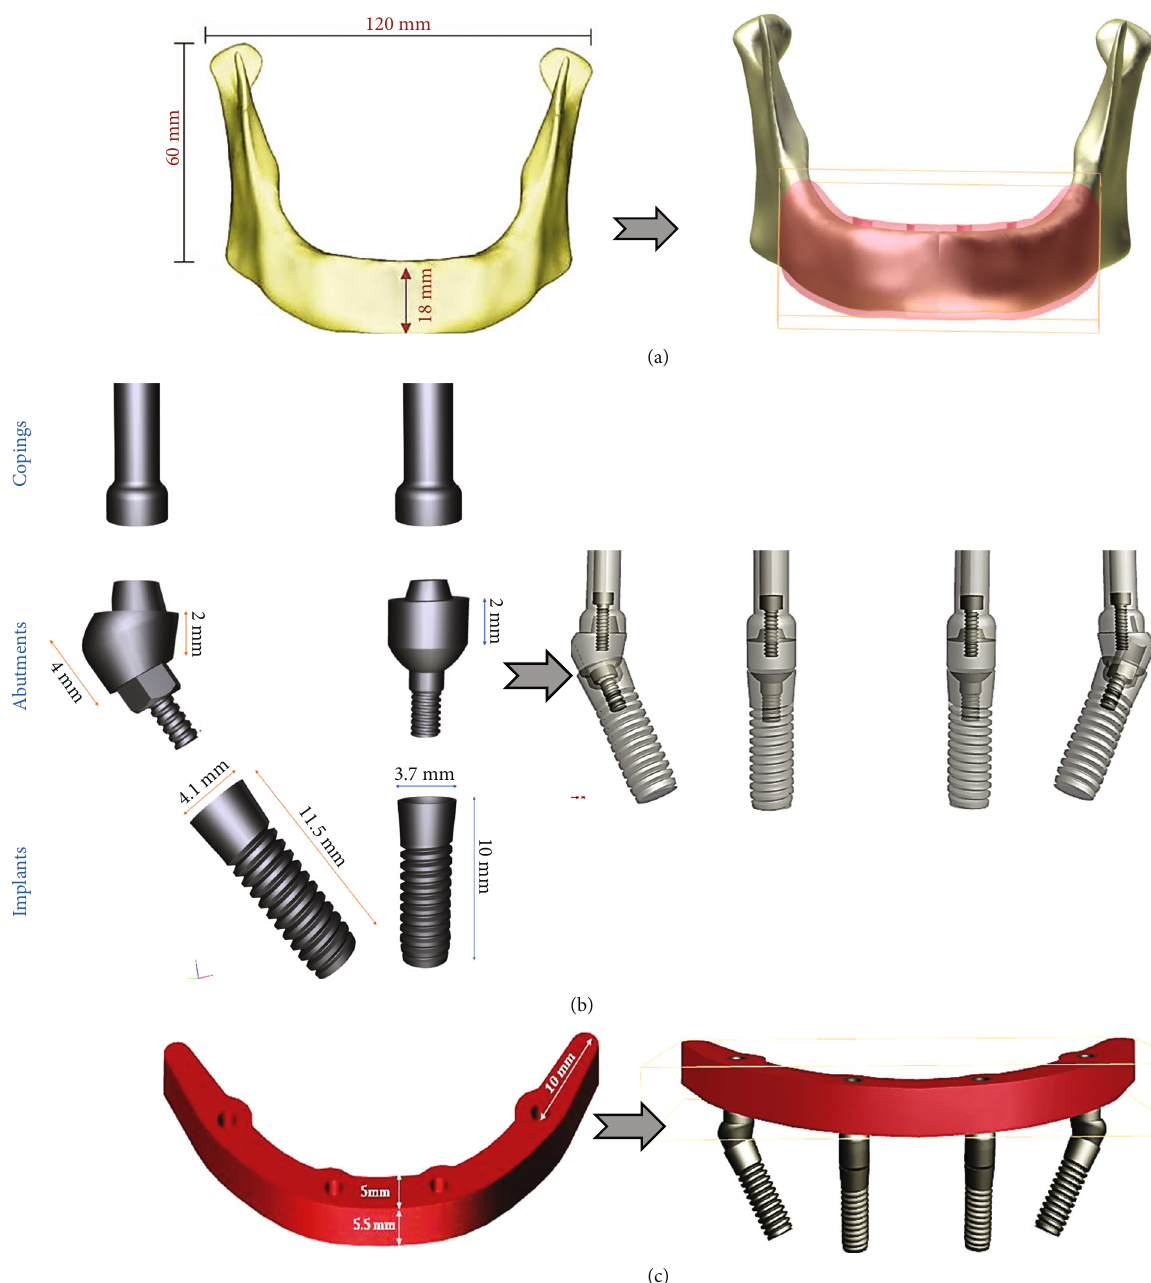
Figure 1: The construction of model parts. (a) Mandible bone & mucosa. (b) Implants, abutments and copings. (C) Framework in “ All on four ”